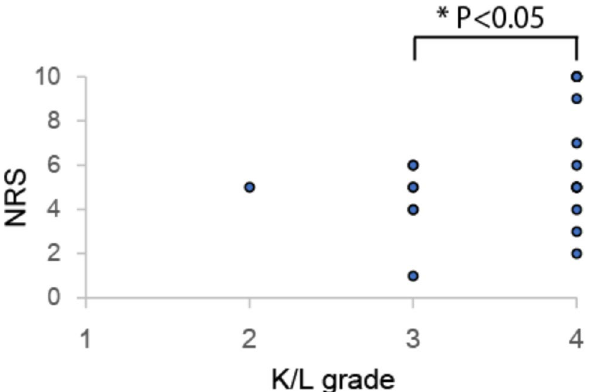
Figure 5. Kellgren/Lawrence grades are associated with NRS before THA surgery. Hip pain, as determined by NRS, was significantly greater in patients with K/L = 4 than those with K/L = 3. One osteonecrosis patient was excluded from analysis because their K/L grade was a classification adapted to OA, and osteonecrosis is known to cause strong pain with less radiographic